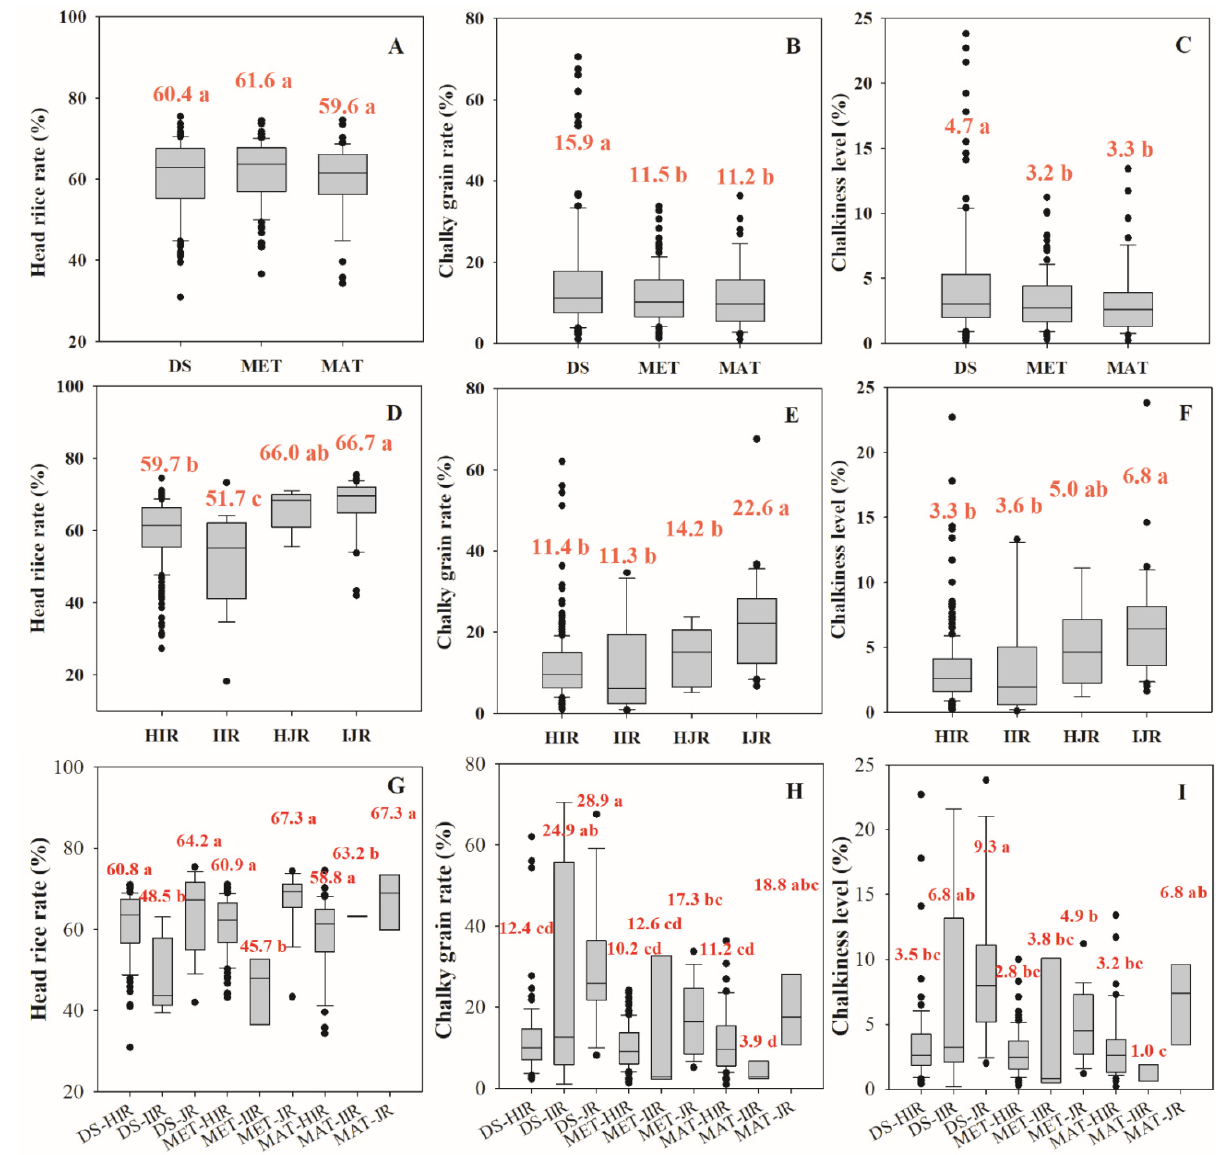
Figure 4. Differences in rice grain quality across different establishment methods (( A ) head rice rate; ( B ) chalky grain rate; ( C ) chalkiness level), different types of rice (( D ) head rice rate; ( E ) chalky grain rate; ( F ) chalkiness level) and their interactions (( G ) head rice rate; ( H ) chalky grain rate; ( I ) chalkiness level). DS, MET, and MAT represent directed seeded, mechanical, and manual transplanted method. HIR, IIR, HJR, and IJR represent hybrid indica rice, inbred indica rice, hybrid japonica rice, and inbred japonica rice, respectively. JR represents japonica rice (including hybrid and inbred japonica rice). The red data is the average value of each series. The same letters are not significantly different at p = 0.05. Data were pooled from examinations conducted in 2020.